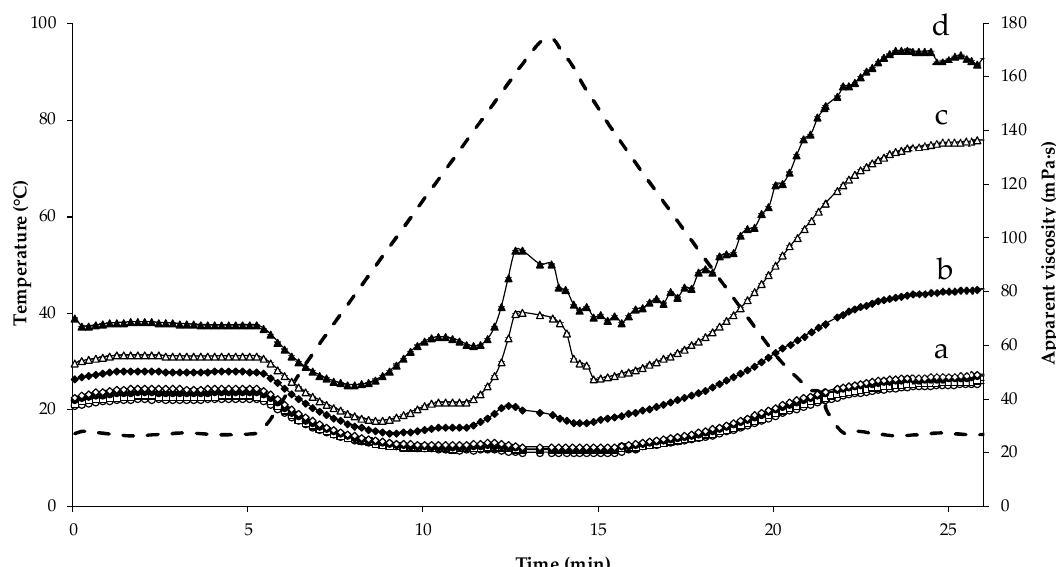
Time (min) Figure 2. Apparent viscosity profiles of lentil protein-stabilised emulsions with 0 ( Figure 2. Apparent viscosity profiles of lentil protein-stabilised emulsions with 0 ( ), 2 ( ), 3 ( Figure 2. Apparent viscosity profiles of lentil protein-stabilised emulsions with 0 ( Figure 2. Apparent viscosity profiles of lentil protein-stabilised emulsions with 0 ( Figure 2. Apparent viscosity profiles of lentil protein-stabilised emulsions with 0 ( Figure 2. Apparent viscosity profiles of lentil protein-stabilised emulsions with 0 ( Figure 2. Apparent viscosity profiles of lentil protein-stabilised emulsions with 0 ( Figure 2. Apparent viscosity profiles of lentil protein-stabilised emulsions with 0 ( Figure 2. Apparent viscosity profiles of lentil protein-stabilised emulsions with 0 ( Figure 2. Apparent viscosity profiles of lentil protein-stabilised emulsions with 0 ( Figure 2. Apparent viscosity profiles of lentil protein-stabilised emulsions with 0 ( ) mM calcium chloride during heat treatment ), 4 ( ), 5 ( ), 6 ( ) and 10 ( ) mM calcium chloride during heat treatment ) mM calcium chloride during heat treatment ) mM calcium chloride during heat treatment ) mM calcium chloride during heat treatment ) mM calcium chloride during heat ) mM calcium chloride during heat treatment ) mM calcium chloride during heat treatment with peak temperature hold at 95°C for 30 s using a starch pasting cell. Dashed line ( ) represents the with peak temperature hold at 95°C for 30 s using a starch pasting cell. Dashed line ( ) represents the with peak temperature hold at 95°C for 30 s using a starch pasting cell. Dashed line ( ) represents the with peak temperature hold at 95°C for 30 s using a starch pasting cell. Dashed line ( ) represents the with peak temperature hold at 95°C for 30 s using a starch pasting cell. Dashed line ( ) represents the with peak temperature hold at 95°C for 30 s using a starch pasting cell. Dashed line ( ) represents the with peak temperature hold at 95°C for 30 s using a starch pasting cell. Dashed line ( ) represents the with peak temperature hold at 95°C for 30 s using a starch pasting cell. Dashed line ( ) represents the treatment with peak temperature hold at 95 ◦ C for 30 s using a starch pasting cell. Dashed line ( with peak temperature hold at 95°C for 30 s using a starch pasting cell. Dashed line ( ) represents the with peak temperature hold at 95°C for 30 s using a starch pasting cell. Dashed line ( ) represents the temperature profile. (a–d) The statistical analysis was performed on the final viscosity of the samples; samples not temperature profile. (a–d) The statistical analysis was performed on the final viscosity of the samples; samples not temperature profile. (a–d) The statistical analysis was performed on the final viscosity of the samples; samples not temperature profile. (a – d) The statistical analysis was performed on the final viscosity of the samples; samples not temperature profile. (a–d) The statistical analysis was performed on the final viscosity of the samples; samples not temperature profile. (a–d) The statistical analysis was performed on the final viscosity of the samples; samples not temperature profile. (a–d) The statistical analysis was performed on the final viscosity of the samples; samples not temperature profile. (a–d) The statistical analysis was performed on the final viscosity of the samples; samples not temperature profile. (a – d) The statistical analysis was performed on the final viscosity of the samples; samples not represents the temperature profile. (a–d) The statistical analysis was performed on the final viscosity of temperature profile. (a–d) The statistical analysis was performed on the final viscosity of the samples; samples not sharing a common letter differed significantly ( p < 0.05). sharing a common letter differed significantly ( p < 0.05). sharing a common letter differed significantly ( p < 0.05). sharing a common letter differed significantly ( p < 0.05). sharing a common letter differed significantly ( p < 0.05). sharing a common letter differed significantly ( p < 0.05). sharing a common letter differed significantly ( p < 0.05). sharing a common letter differed significantly ( p < 0.05). sharing a common letter differed significantly ( p < 0.05). sharing a common letter differed significantly ( p < 0.05). the samples; samples not sharing a common letter di ff ered significantly ( p < 0.05).